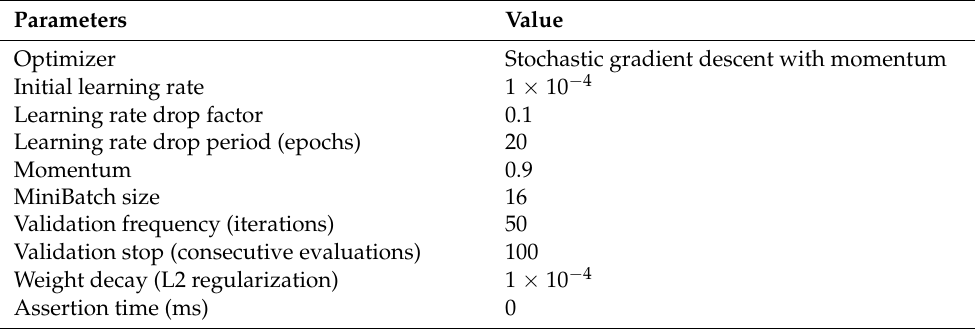
Table 7. CNN training parameters.